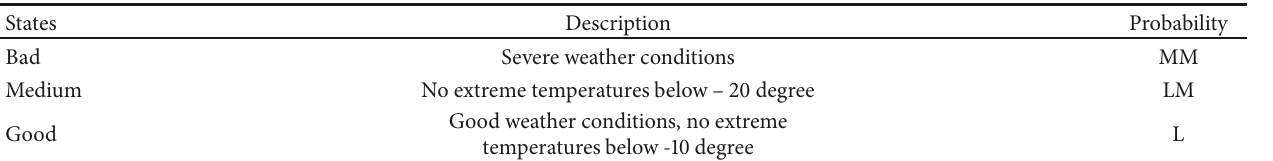
Table 3: Prior probability of weather